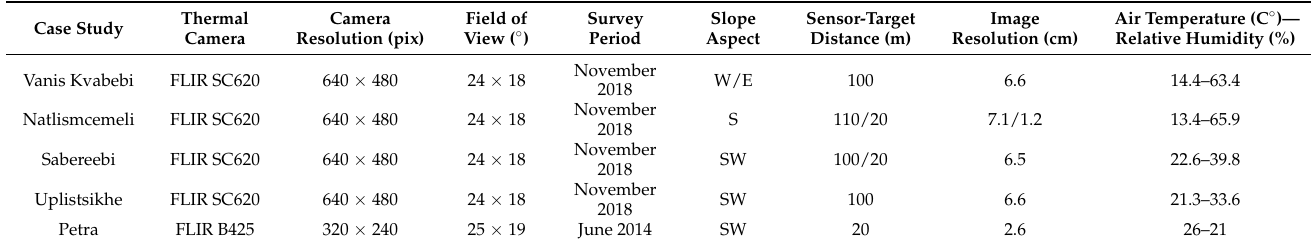
was also used to create classified surface temperature maps using quantile function [63]. Table 1. IRT survey parameters of the analysed sites.